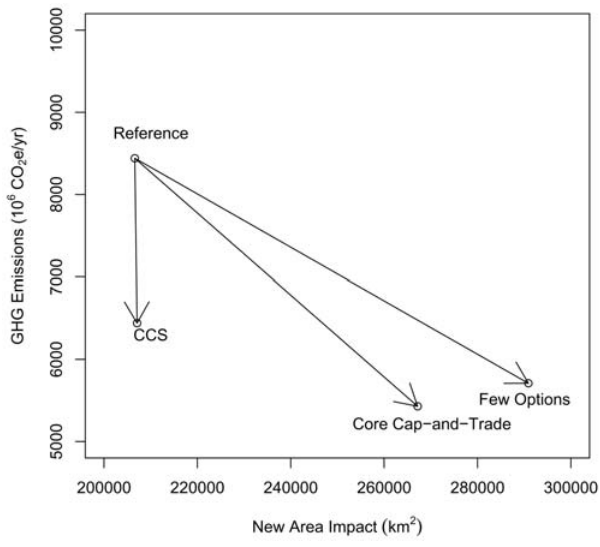
Figure 4. Greenhouse gas emissions and total new area impacted with a cap-and-trade system. Arrows depict the difference between the Reference Scenario, with no cap-and-trade system, and three other scenarios where a cap-and-trade system is implemented. Greenhouse gas emissions measured in million tonnes of carbon dioxide equivalent.